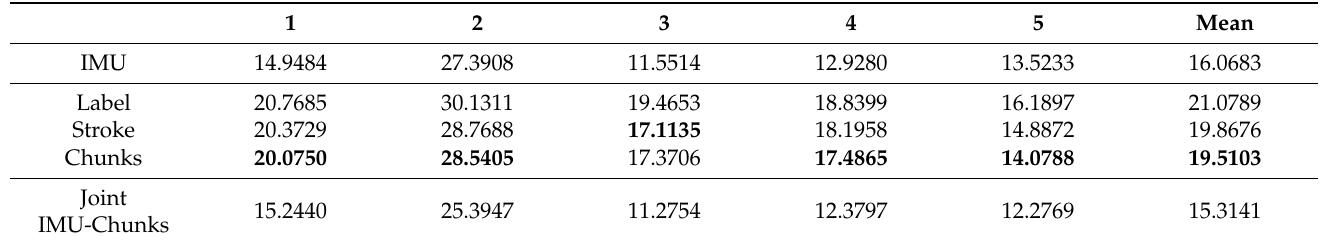
Table 6. Character error rates over the five folds of the paper data using IMU data and generated